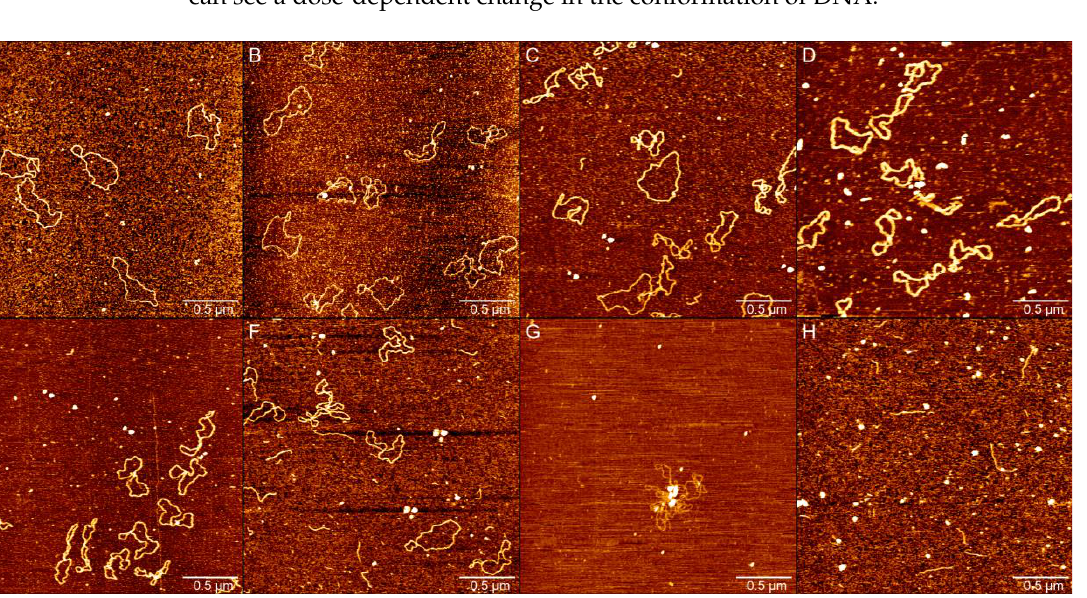
1 mM. We can see a dose-dependent change in the conformation of DNA.